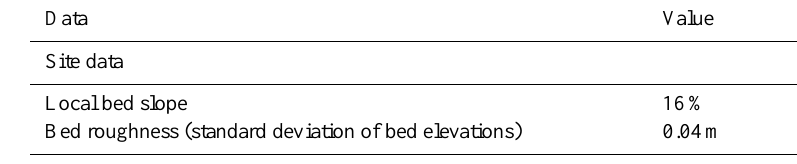
Table 1. Event statistics. Values are given for the event period, unless otherwise